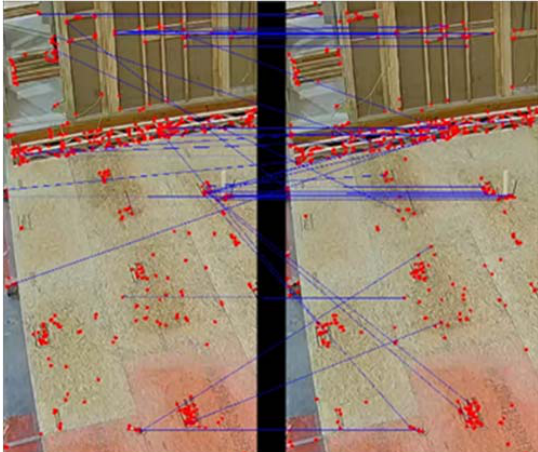
Figure 15. Matching the query frame, on the left, with ‘occupied’ ground truth on the right.